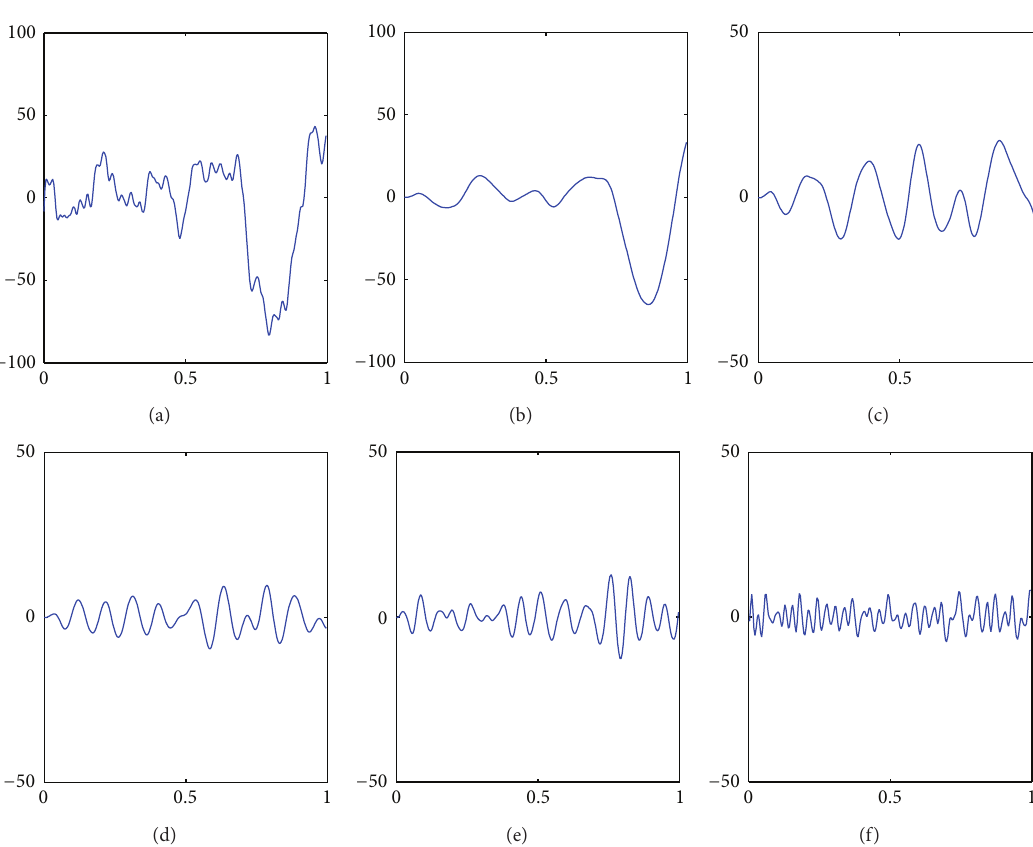
Figure 2: EEG frequency waveform. (a) One second of EEG signal. (b) Delta wave. (c) Theta wave. (d) Alpha wave. (e) Beta wave. (f) Gamma